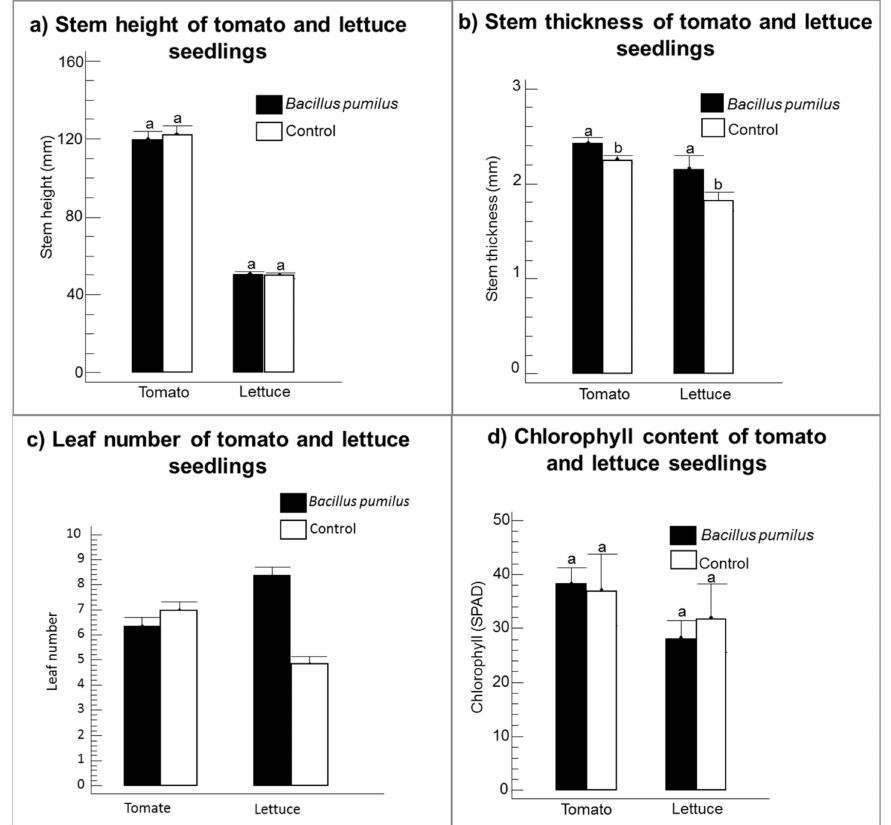
Figure 5. Effect of Bacillus pumilus inoculation for 5 weeks on height ( a ), stem thickness ( b ), number of leaves ( c ), and chlorophyll content ( d ) in tomato and lettuce seedlings compared with a non- inoculated control. The error bars represent the standard deviation. The different letters indicate statistically significant differences between the Tukey treatments for p =